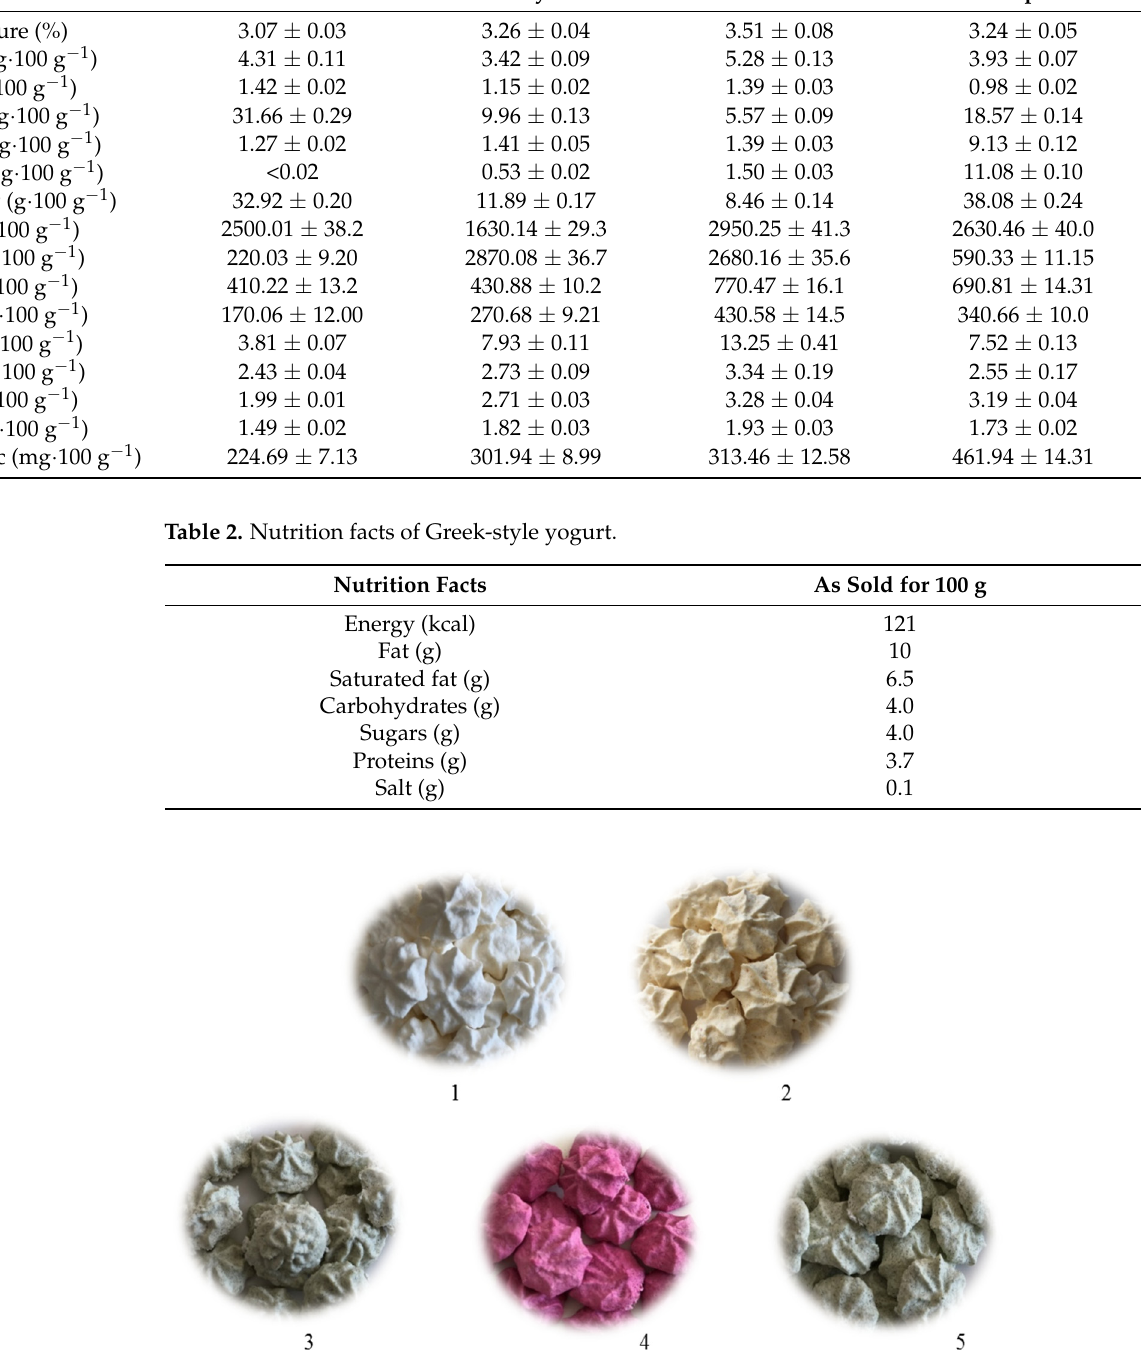
Table 1. Chemical composition of freeze-dried plant raw material powders, DM.